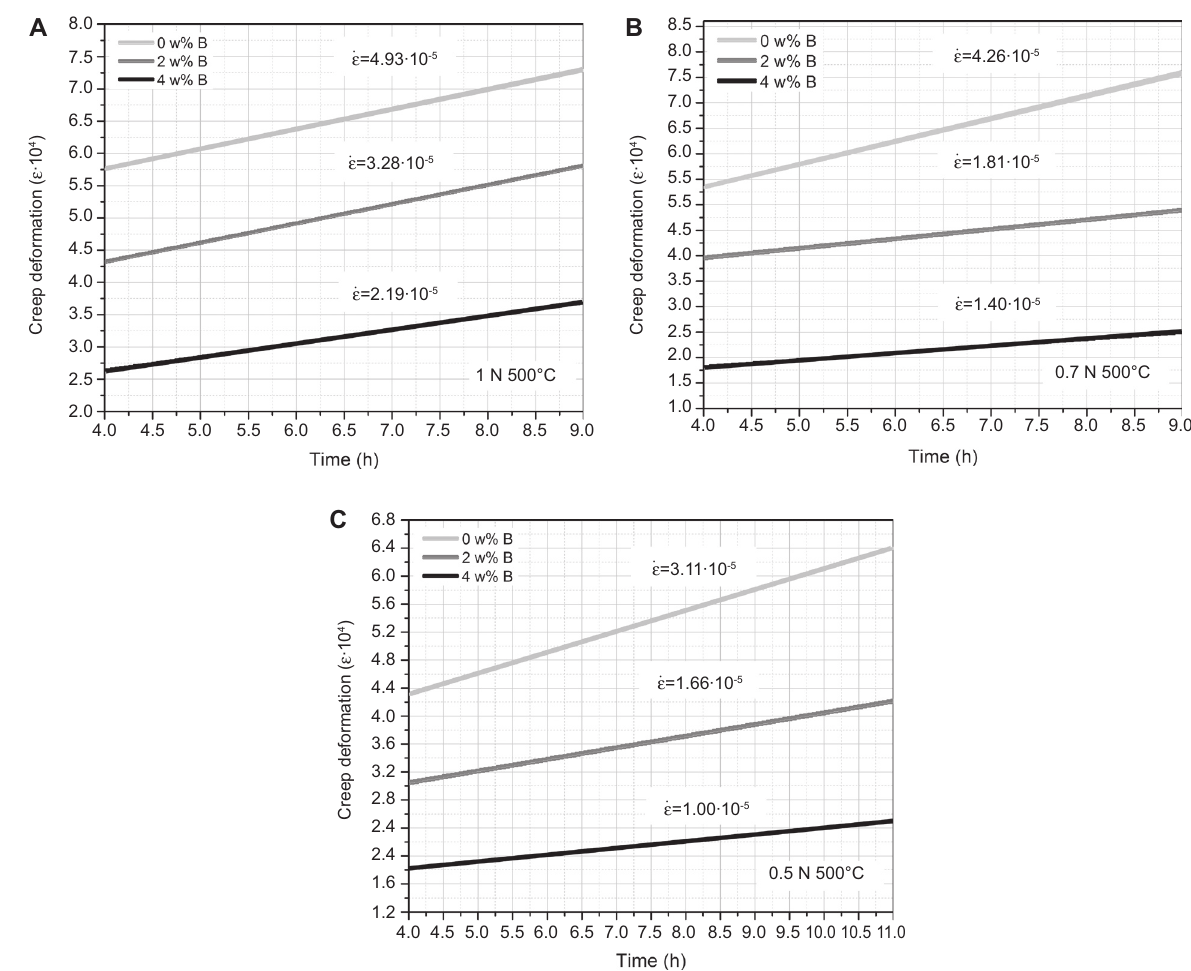
particles at 500 ° C and different loads: (A) 1 N, (B) 0.7 N, (C) 0.5 N. 2